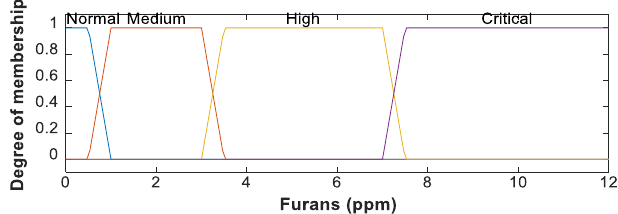
Figure 1. Membership functions for furan content.